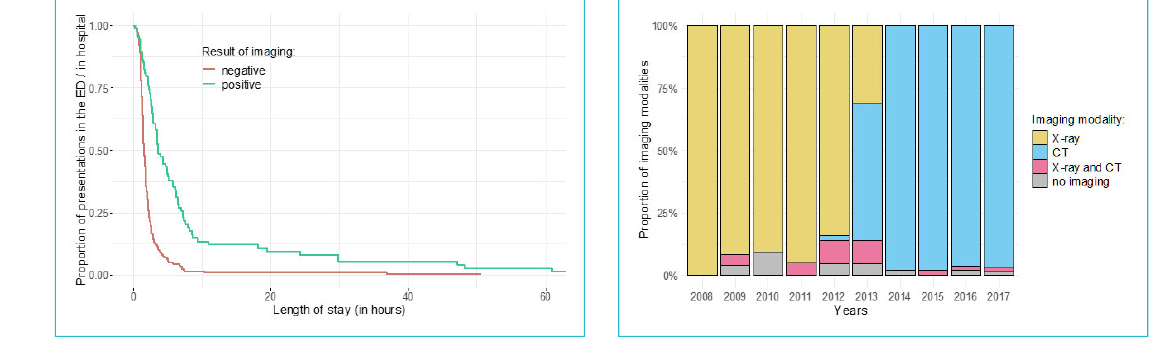
Figure 4: Imaging modalities in presentations with suspicion of in- tracorporeal drug transport for the years 2008 to